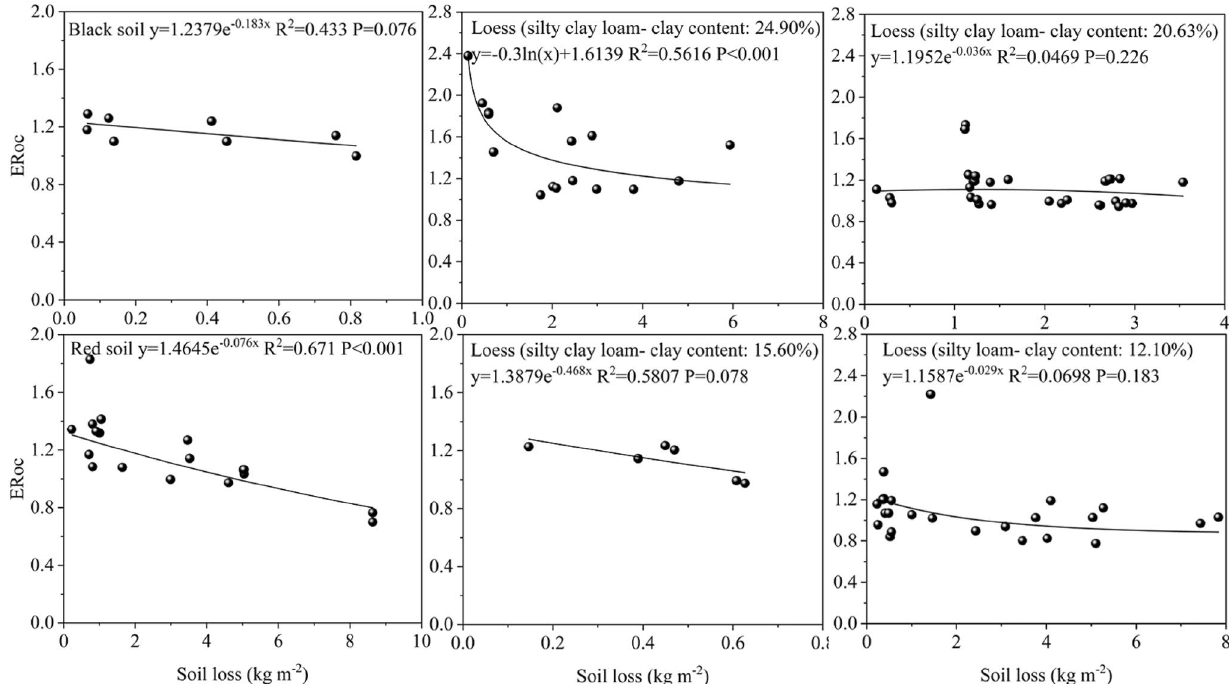
Fig. 7 Relationships between total soil loss and